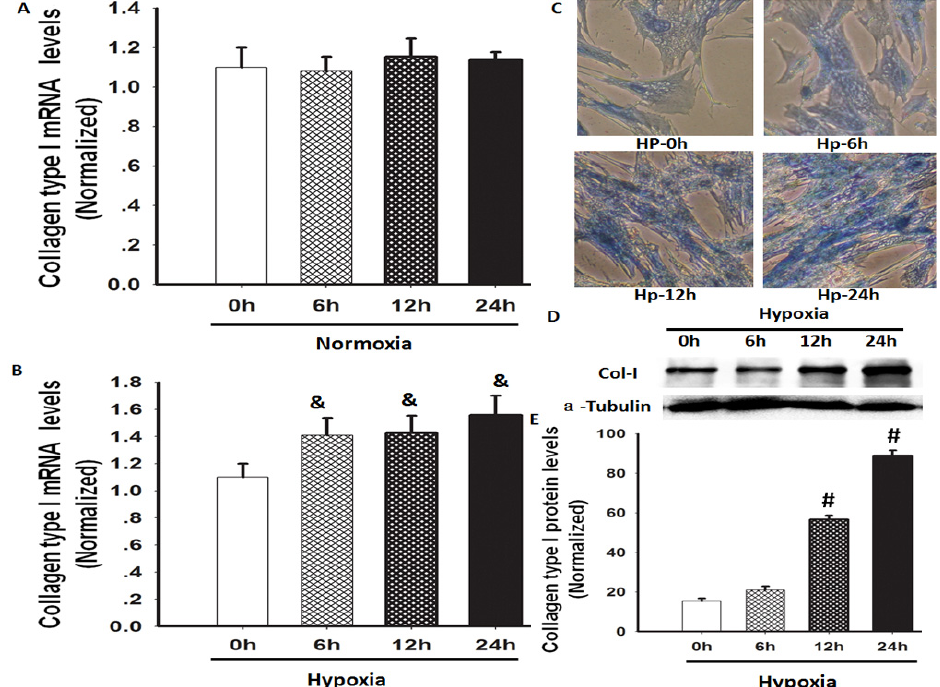
Figure 1. The effects of hypoxia on the total collagen content and Col-I mRNA and protein levels of HLF-1 cells. ( A , B ) Col-I mRNA expression was detected using real-time polymerase chain reaction (RT-PCR) in HLF-1 cells cultured for 0, 6, 12 and 24 h under normoxic or hypoxic conditions. The data are presented as means ± standard deviation (SD) ( n = 3). & p < 0.05 vs. hypoxia-treated cells at 0 h; ( C ) Masson staining assay was used to observe the changes to the total collagen content in HLF-1 cells cultured under hypoxia for different time periods, as indicated. The total collagen content was increased in a time-dependent fashion after the hypoxic treatment; ( D ) Col-I protein expression was measured using Western blot analysis; and ( E ) Normalisation of the Col-I expression to α -tubulin. The data are presented as means ± SD ( n = 3). # p < 0.05 vs. 0 h following hypoxia